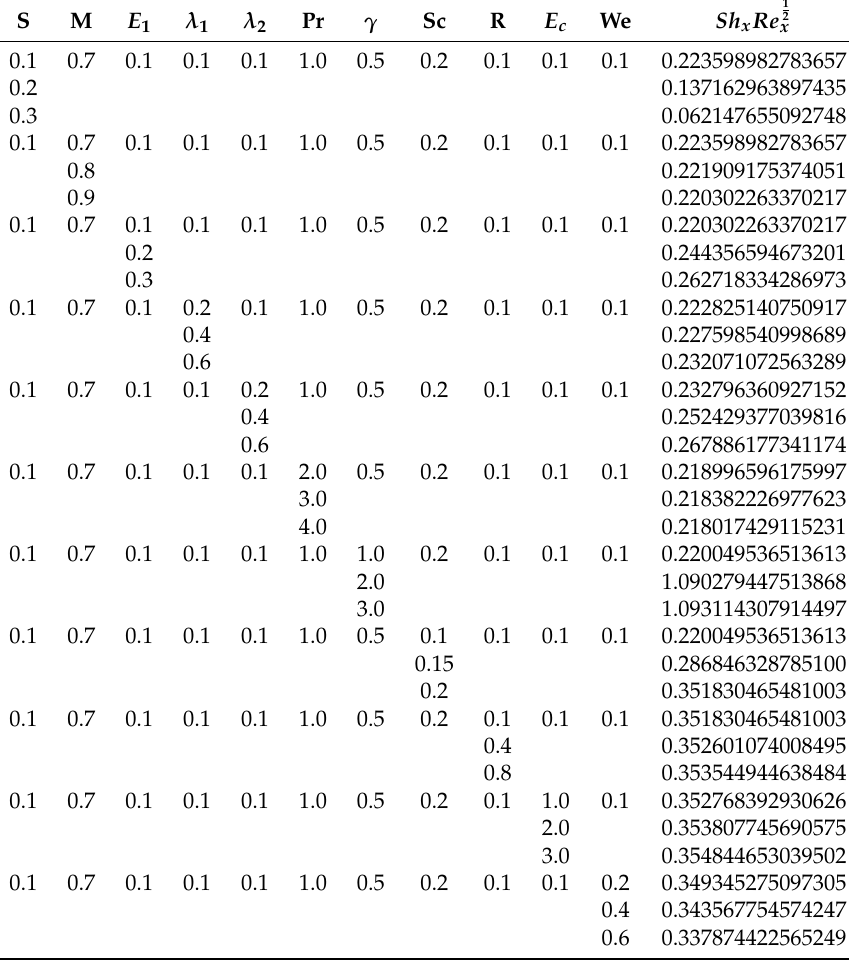
Table 3. The numerical values of Sh x Re Pr , R , E c , γ and Sc when η =